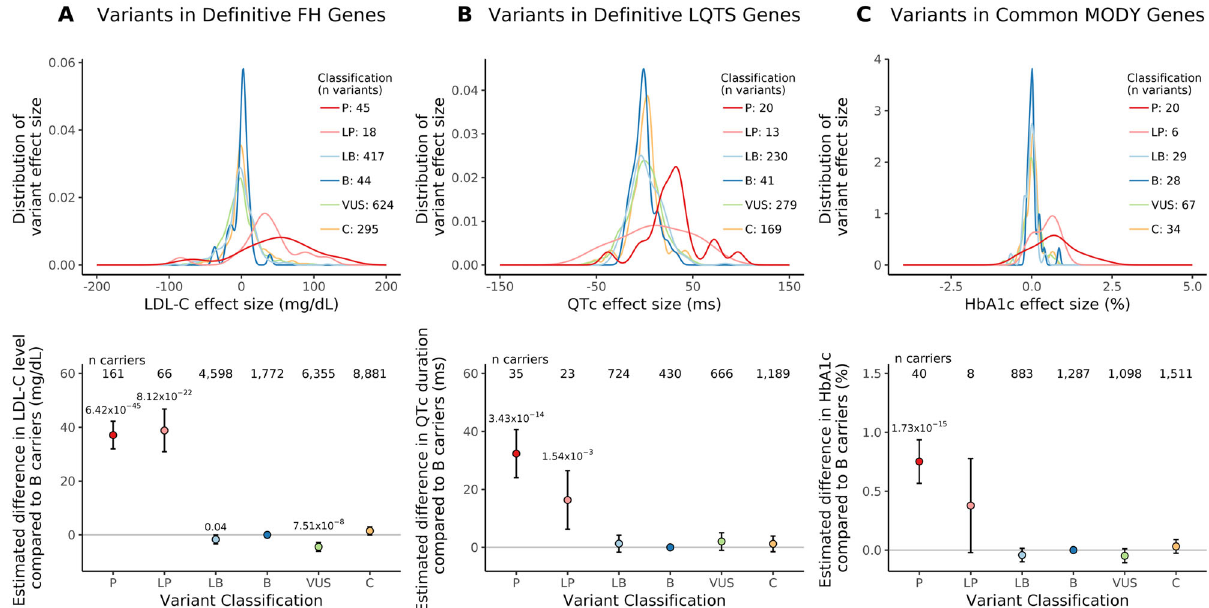
Fig. 1 | Association between effect size and variant pathogenicity for three monogenicdiseaseendophenotypes.A , B ,and C displaydatafortheLDL-C,QTc, and HbA1c endophenotypes, respectively, for rare variants found in the UK Bio- bank. De fi nitive familial hypercholesterolemia (FH) genes include LDLR, APOB, PCSK9 ; de fi nitive long-QT syndrome (LQTS) genes include KCNQ1, KCNH2, SCN5A ; common maturity-onset diabetes of the young (MODY) genes include HNF1A, HNF1B,HNF4A,GCK .Row1ineachpaneldisplaysthevarianteffectsizedistribution